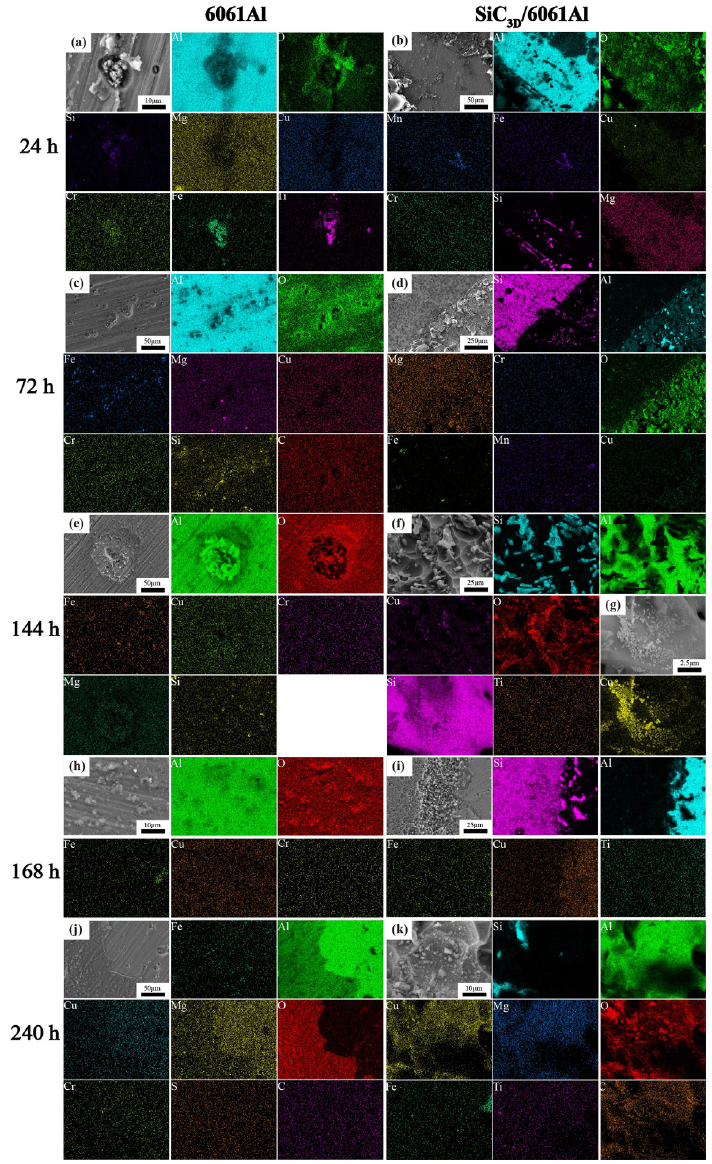
Figure 8. Energy dispersive X-ray spectrometer (EDS) of corrosion products with different times after NSS corrosion. ( a , c , e , h , j ) 6061Al; ( b , d , f , g , I , k ) SiC 3D /6061Al.